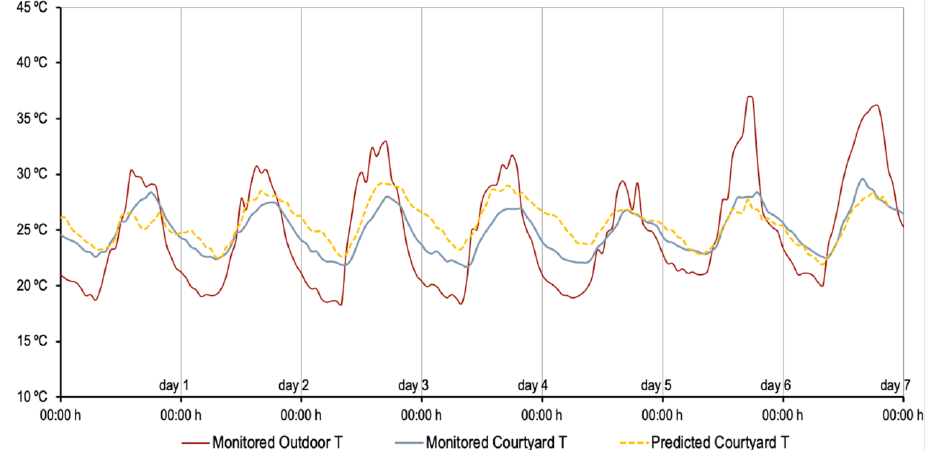
Figure 8. Example 3.0.2. Predicted temperature versus monitored and outdoor temperatures inside an ARII.2